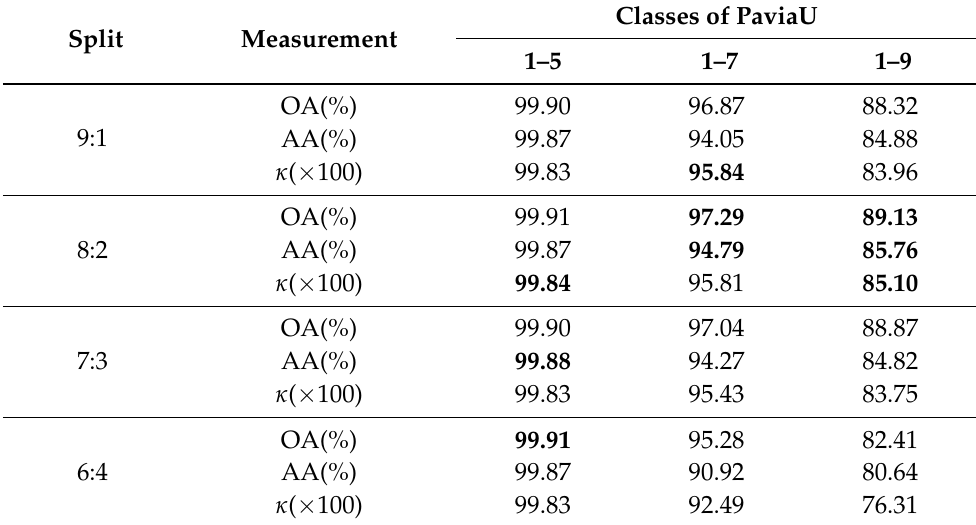
Table 5. Classification results of different split ratio of